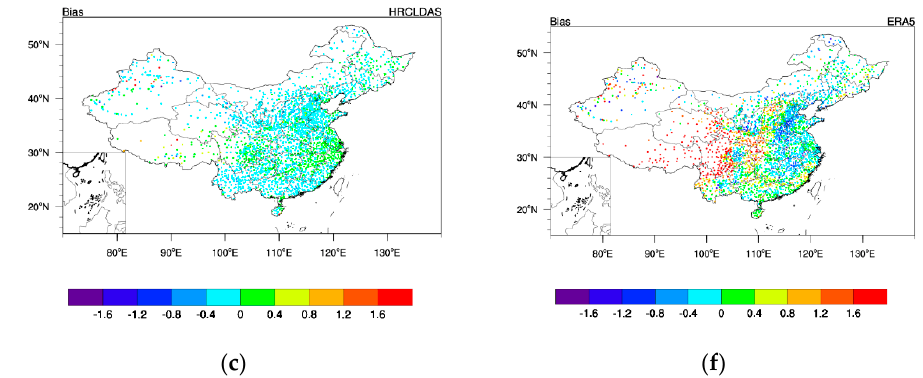
Figure 2. Spatial distribution of correlation coefficient (COR), root-mean-square error (RMSE) and bias between the daily mean air temperature of HRCLDAS and ERA5 and the observed daily mean air temperature. ( a – c ) represent the spatial distribution of COR, RMSE and bias of HRCLDAS, respectively; ( d – f ) represent the spatial distribution of COR, RMSE and bias of ERA5, respectively.